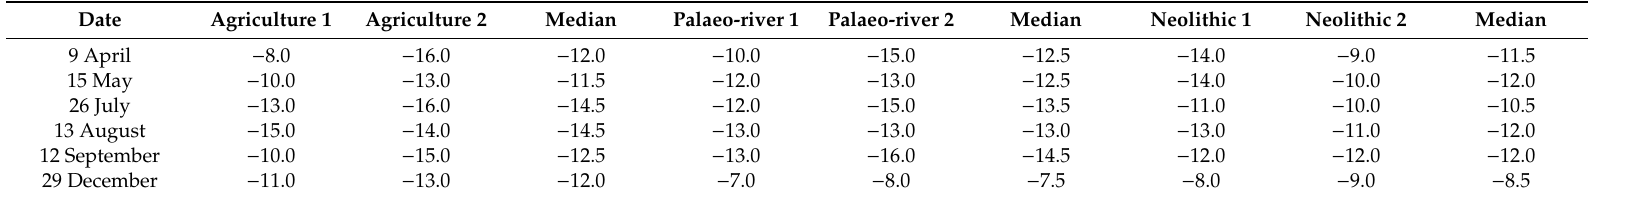
Table A3. Backscatter values for the Sentinel 1 2019 Sigma0-VV descending pass direction.